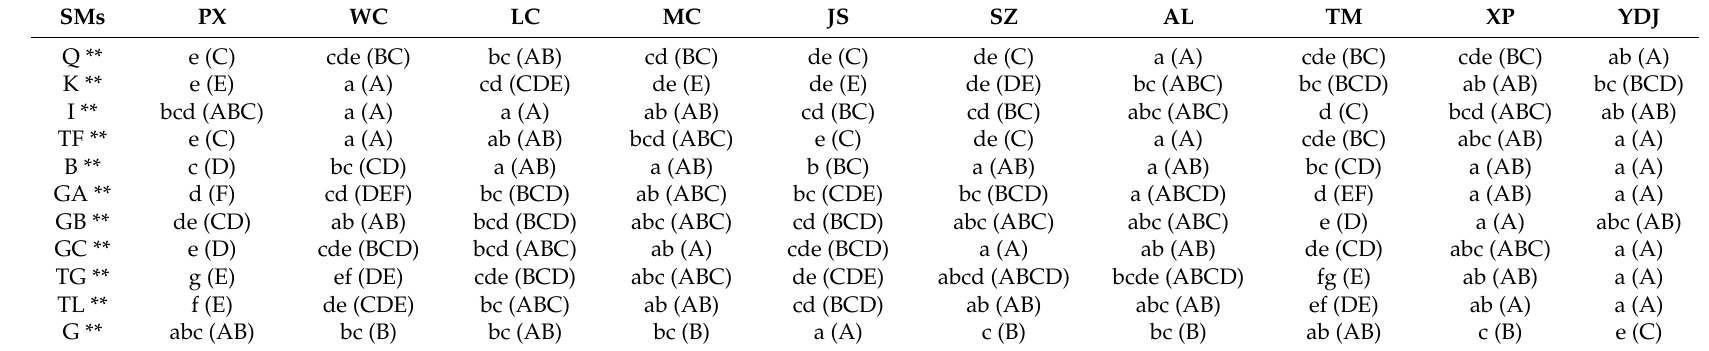
Table 2. Differences in SMs concentrations in dry leaves from different G. biloba